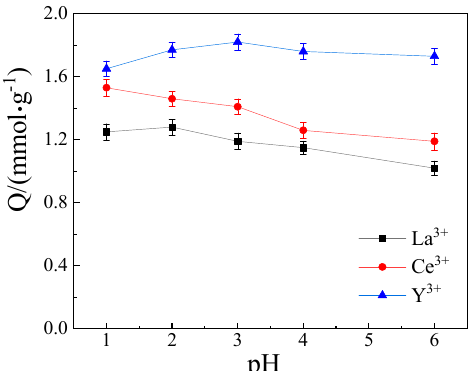
Figure 5. E ff ect of pH values on the resin ( C 0 = 0.01 mol · L − 1 , t = 4 h, T = 40 ◦ Figure 5. Effect of （ pH values on the resin C 0 = 0.01 mol·L − 1 , t = 4 h, T = 40 ℃ ).